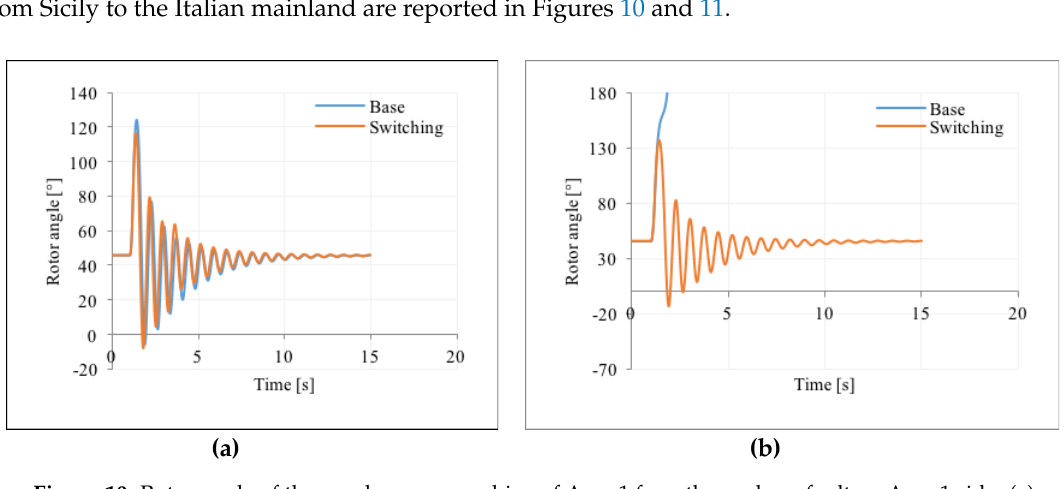
Figure 10. Rotor angle of the synchronous machine of Area 1 for a three-phase fault on Area 1 side: ( a ) Time results for clearing fault time t clear = 170 ms; ( b ) Time results for clearing fault time t clear = 191 ms (critical clearing time t CCT ).